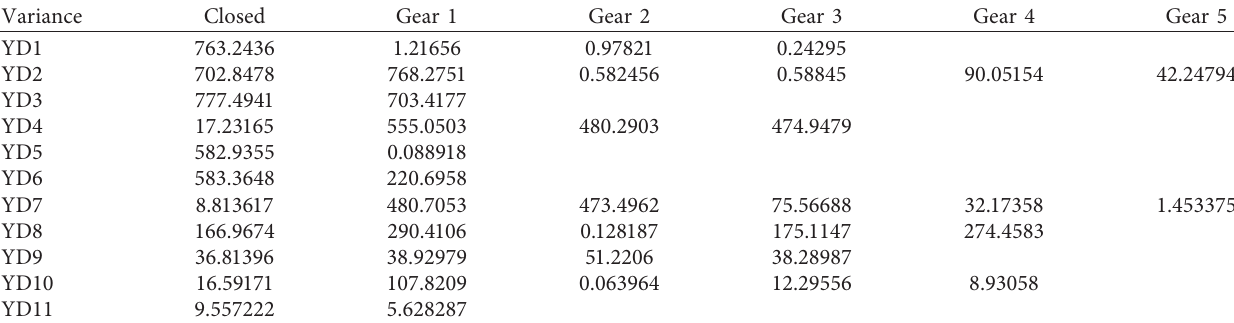
Table 5: Variance of harmonic content rate under each operating state of the device.